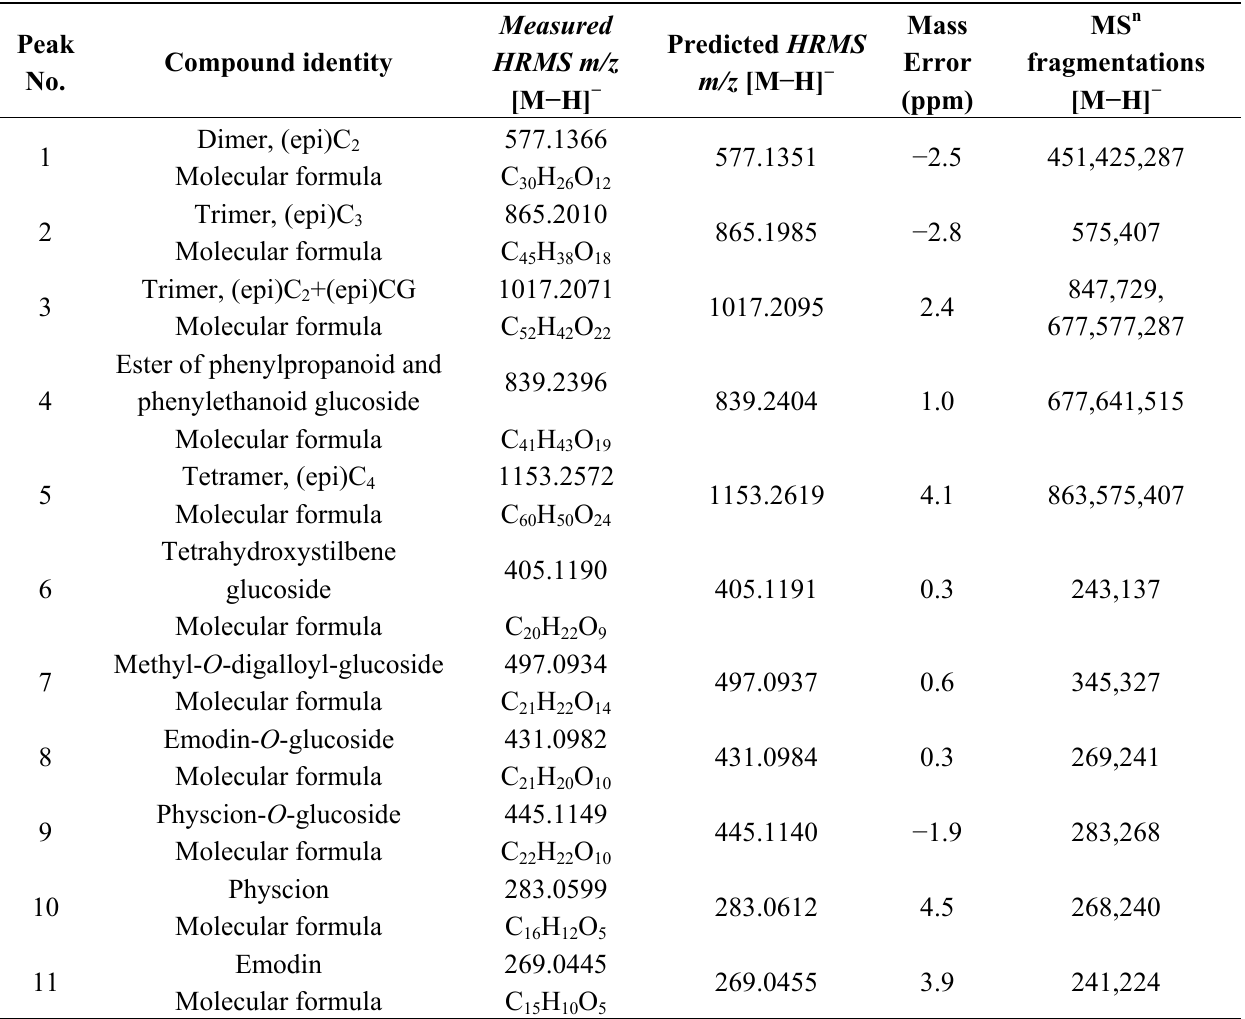
Table 1. LC-HR-MS and LC-MS n data for